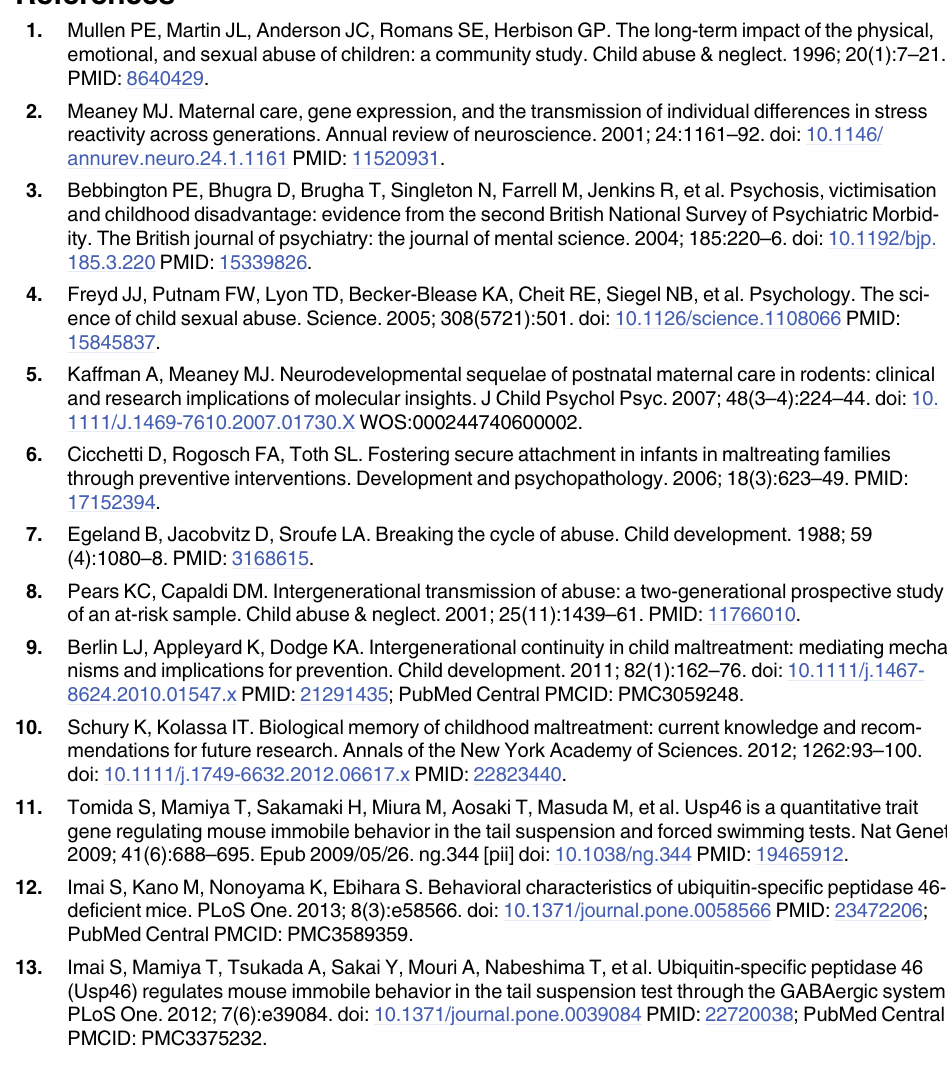
S1 Table. Results of pup-retrieval test. S2 Table. The ARRIVE guidelines